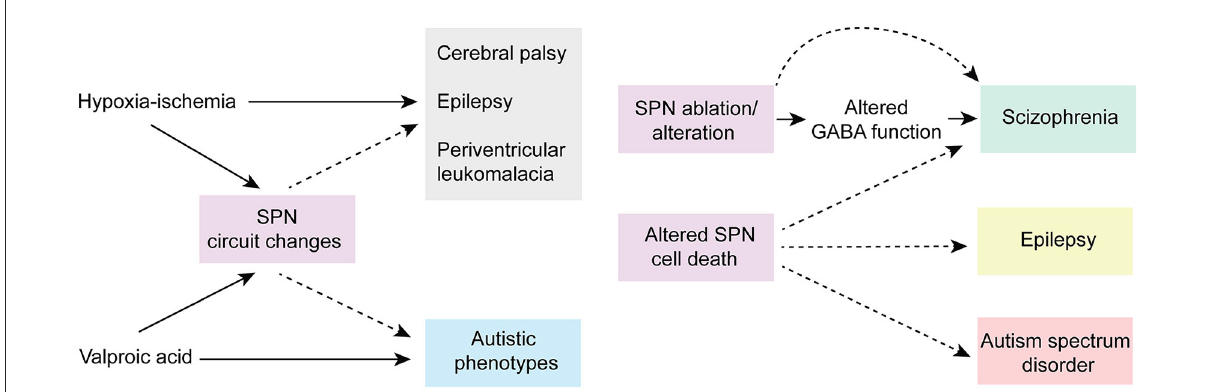
FIGURE5 Predicted roles of SPN abnormality in neurodevelopmental disorders. Cartoon depicting possible involvement of SPN abnormality in neurodevelopmental and neuropsychiatric disorders based on existing experimental and clinical data. Solid arrows indicate direct experimental evidence. Dashed arrows indicate speculative assumptions based on experimental and indirect clinical